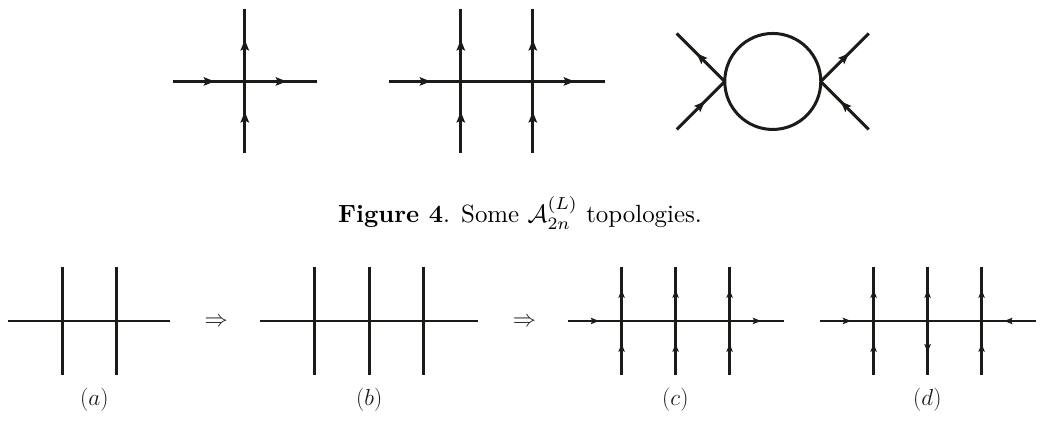
Figure 4 . Some A ( L )